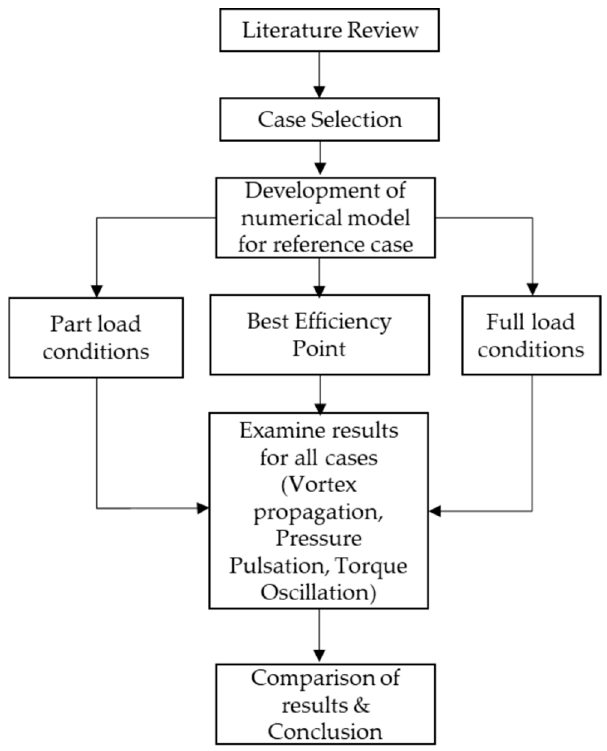
Figure 2. Flow chart showing the methodology adopted in this work.